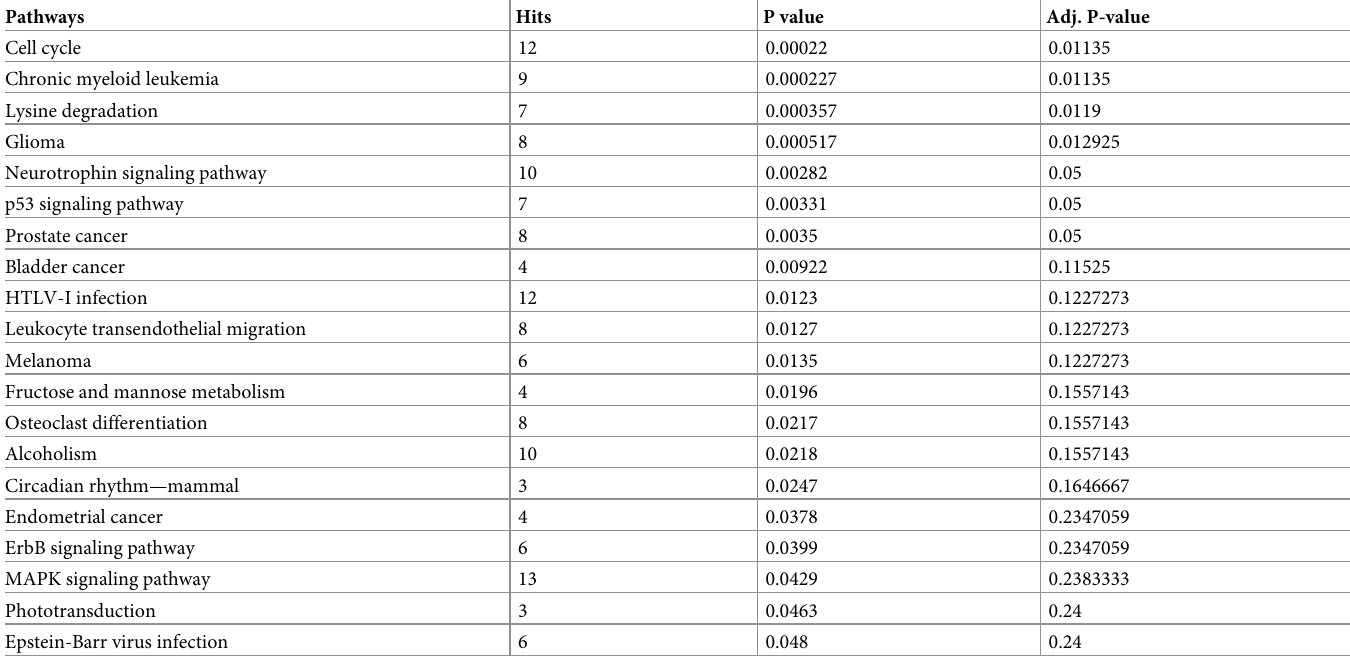
The table shows the relevant pathways associated with the selected 5 miRNAs based on KEGG analysis using